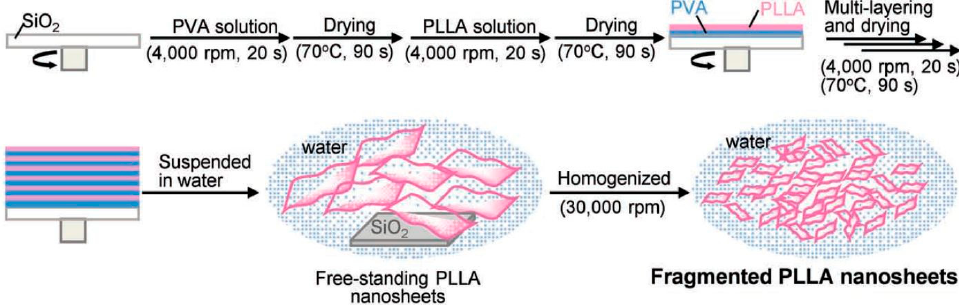
Figure 4. Preparation of fragmented PLLA nanosheets [22].